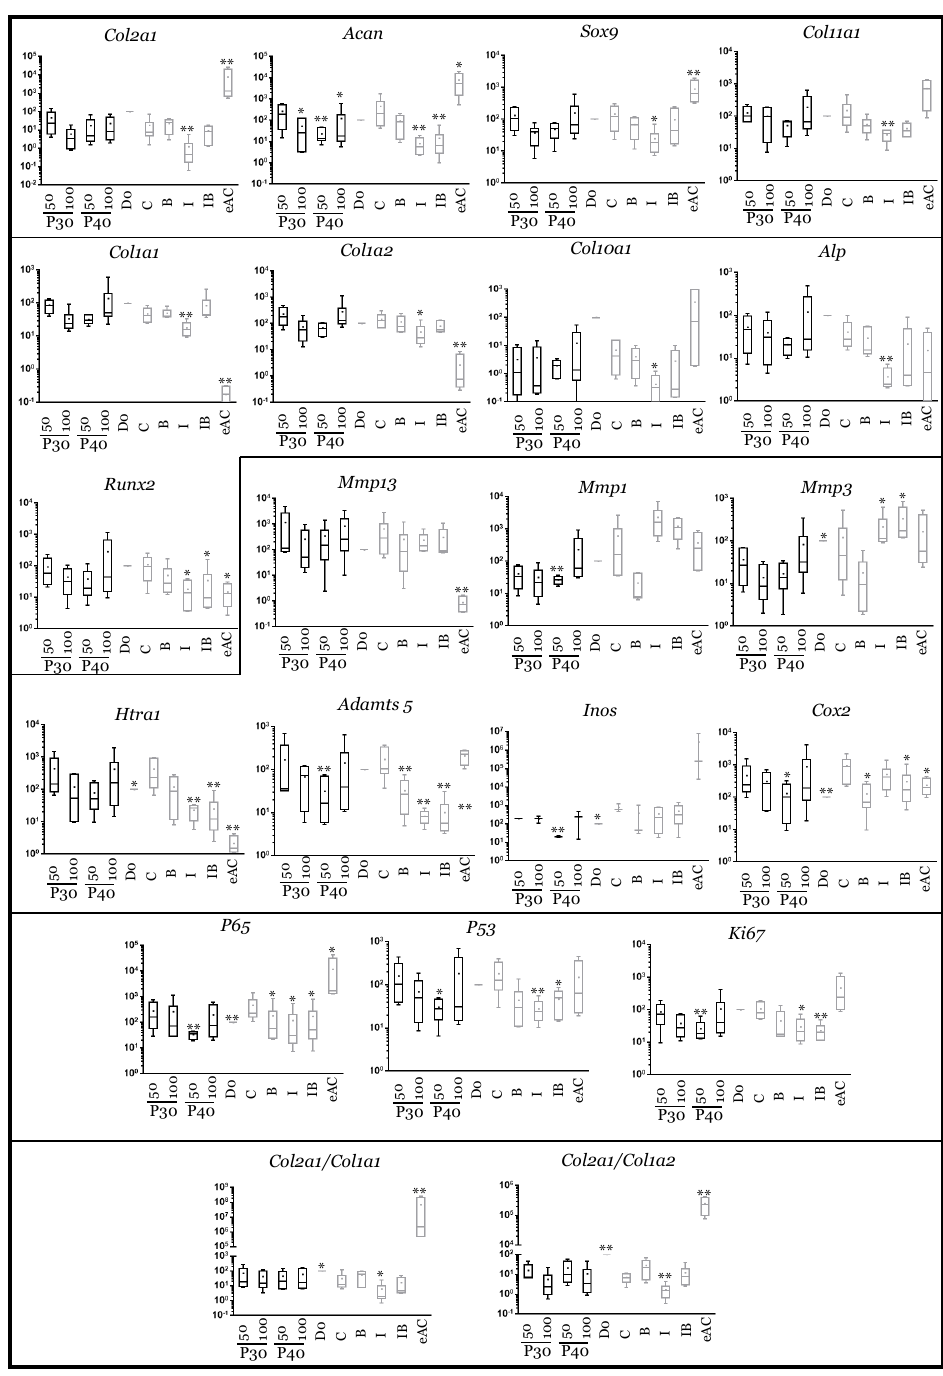
Figure 8. Comparison of mRNA expression in equine articular chondrocytes in the presence or absence of high concentra- tions of Promerim ® 30 and 40. Equine articular chondrocytes were grown in type I/III collagen sponges at the third passage (P3). They were incubated for 7 days in hypoxia in the absence (C: control) or presence of Promerim ® 30 or Promerim ® 40 (P30 and P40) (50 and 100 µ g/mL), or BMP-2 (B), or IL-1 (I), or BMP-2 and IL-1 (IB). At the end of incubation period, their mRNA was extracted as described in Materials and Methods. The mRNAs were estimated using RT-qPCR after normalization with respect to the β -actin reference gene. Transcript expression is shown in arbitrary units. The Col2a1 : Col1a1 and Col2a1 : Col1a2 ratios are given. The results are shown as box plots (median, quartiles, extreme values) and the signifi- cance of the values between the different treatments and the control (C) was tested using a Mann–Whitney test (* p < 0.05; ** p < 0.01); n = 6. eAC: mRNA extracts obtained from equine articular chondrocytes released from cartilage after overnight enzymatic digestion were used as controls. D0: cells seeded in sponges and arrested after 16 h of